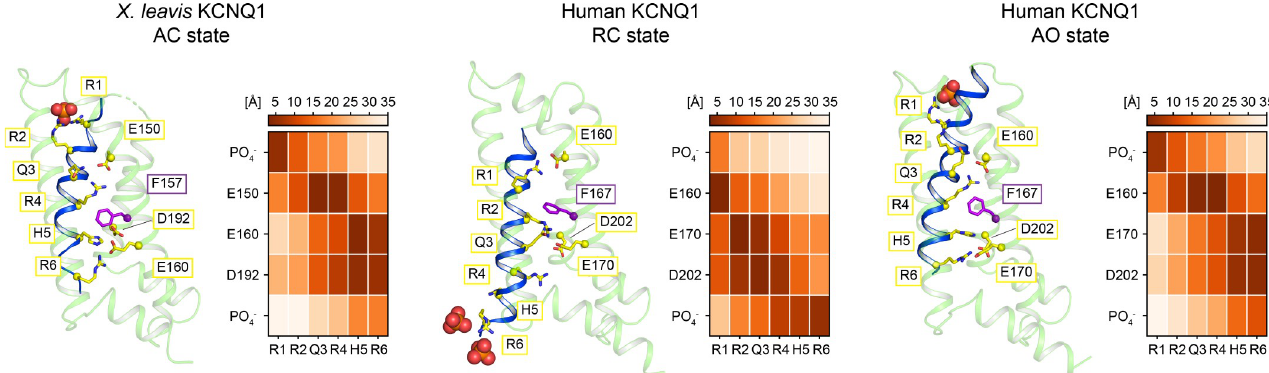
Fig 3. Voltage sensor conformation in the X . leavis KCNQ1 structure and human KCNQ1 RC and AO homology models. Left: VSD conformation; helices S0-S3 are colored pale green and helix S4 is colored blue. The side-chains of positively charged residues on S4 (yellow) and the gating charge transfer center residues E150/E160 (S2, yellow), F157/F167 (S2, magenta), E160/E170 (S2, yellow) and D192/D202 (S3, yellow) are depicted as sticks. Phosphate groups of phospholipids in the outer (top) and inner (bottom) bilayer leaflet are represented as spheres. Right: side-chain–side-chain distances between residues on S4 and gating charge transfer center residues. Values represent the average over four VSD copies, and were calculated from the cryo-EM structure of X . leavis KCNQ1 (after embedding in a POPC bilayer with CHARMM-GUI [47] and short minimization in Amber16 [48]) and from MD simulations of human KCNQ1 models. Distances were measured between the geometric centers of the side-chain atoms H 2 N = C z (NH 2 )-N ε H-C δ H 2 (Arg), H 3 N z -C ε H 2 (Lys), C γ -N δ 1 - C ε 1 H-N ε 2 H-C δ 2 H (His), HOOC γ -C β H 2 (Asp), HOOC ε -C γ H 2 (Glu) and the lipid phosphate group PO 4-